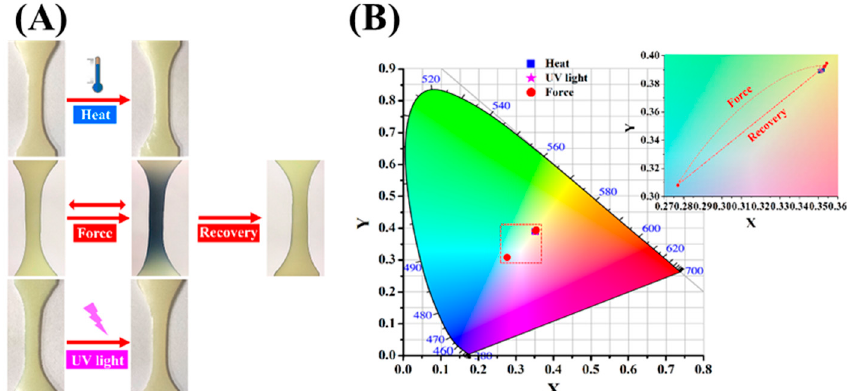
Figure 4. ( A ) Optical images of poly(AM– co –MA/DMSP3) hydrogels under the stimuli of heat, external force ( λ = 3), and UV light, and ( B ) their corresponding CIE color coordinates.